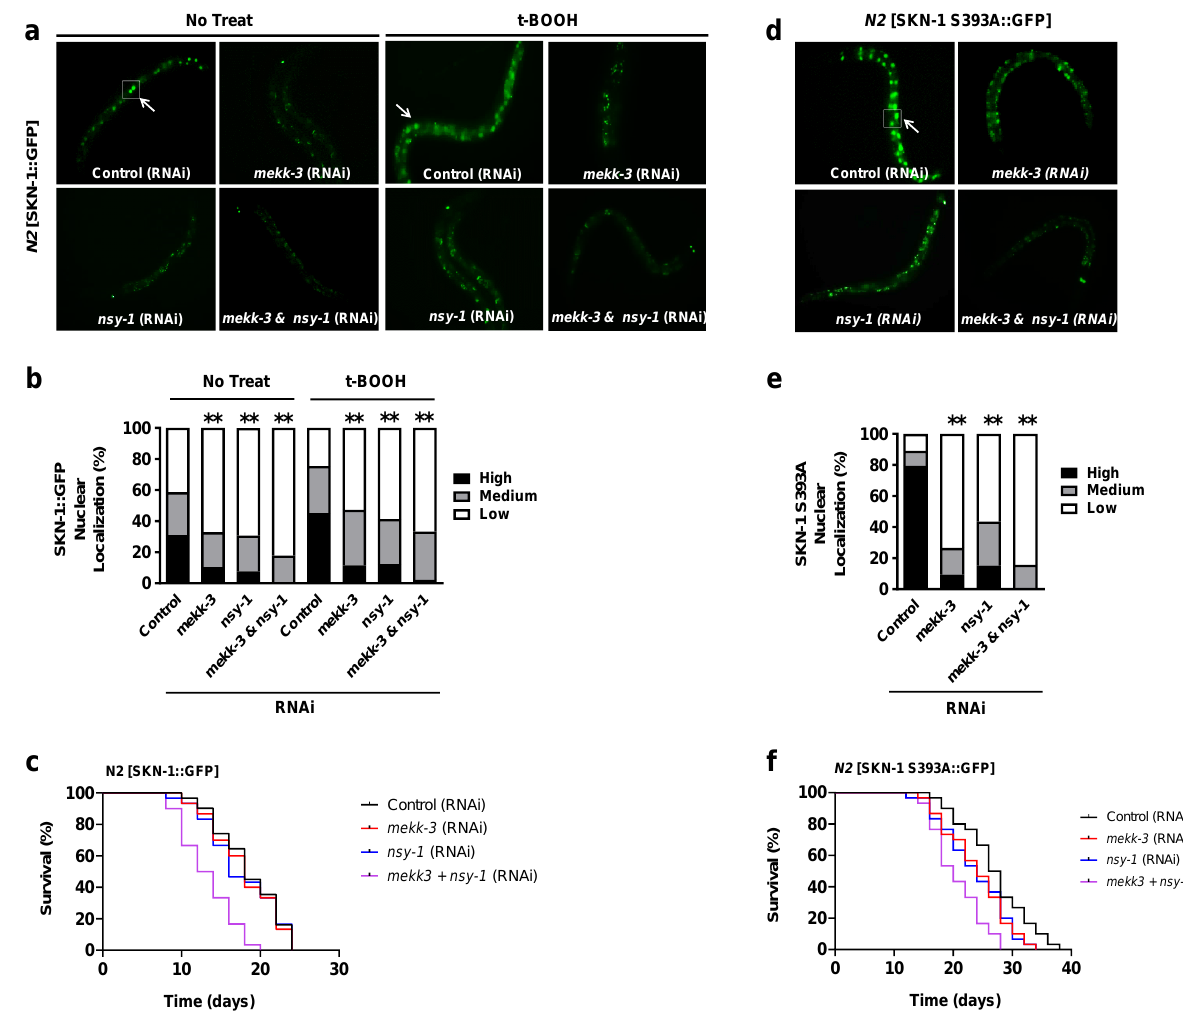
Figure 3. Knockdown of MEKK − 3 and NSY − 1 completely suppresses the nuclear localization of SKN − 1 and SKN − 1 − dependent oxidative stress resistance and longevity. ( a ) The nuclear localization of SKN-1 labeled with GFP in the intestine. SKN-1 transgenic young adult worms were placed on NGM plates that contained either mekk-3 , nsy-1 , or a combination of mekk-3 and nsy-1 RNAi bacteria for 24 h. The L4440 vector without insertion in bacteria was used as a control. Fluorescent images were captured 4 h after the transfer of worms fed RNAi bacteria on the normal (left) or 20 mM t-BOOH (right) plates. The white arrows indicate SKN-1::GFP. ( b ) Young adult worms were scored for accumulation of SKN-1::GFP in the intestinal nuclei (n = 30 in each group). ( c ) Lifespan assay was performed in SKN-1 transgenic worms. Young adult worms were transferred to plates with bacteria containing RNAi plasmids against mekk-3 , nsy-1 , or both mekk-3 and nsy-1 . The L4440 vector without insertion in bacteria was used as a control. The percentage of live animals was plotted at the indicated time points (days). This experiment involved 90 worms in each group. The mean and median lifespan are shown in Table S2. ( d ) The nuclear localization of SKN-1 S393A mutant labeled with GFP. All procedures were performed in the same manner as described in ( a ). SKN-1 nuclear localization of each inset was confirmed by using DAPI staining in Figure S4. ( e ) Quantitative analyses of the fluorescent images of SKN-1 S393A::GFP. All procedures were performed in the same manner as described in ( b ) (n = 30 in each group). ( f ) Lifespan assay was performed in SKN-1 S393A transgenic worms. All procedures were performed in the same manner as described in Figure 1b. This experiment involved 90 worms in each group. The mean and median lifespan are shown in Table S2. ** p < 0.01 compared to control. All p values were calculated by chi 2 tests.